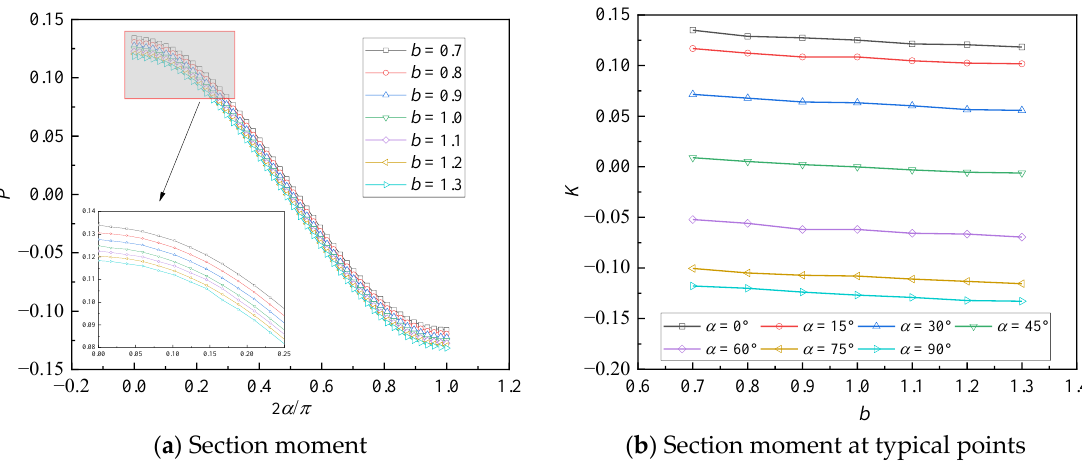
( b ) Radial displacement at typical points Figure 6. Radial displacement in the single factor test of parameter b.